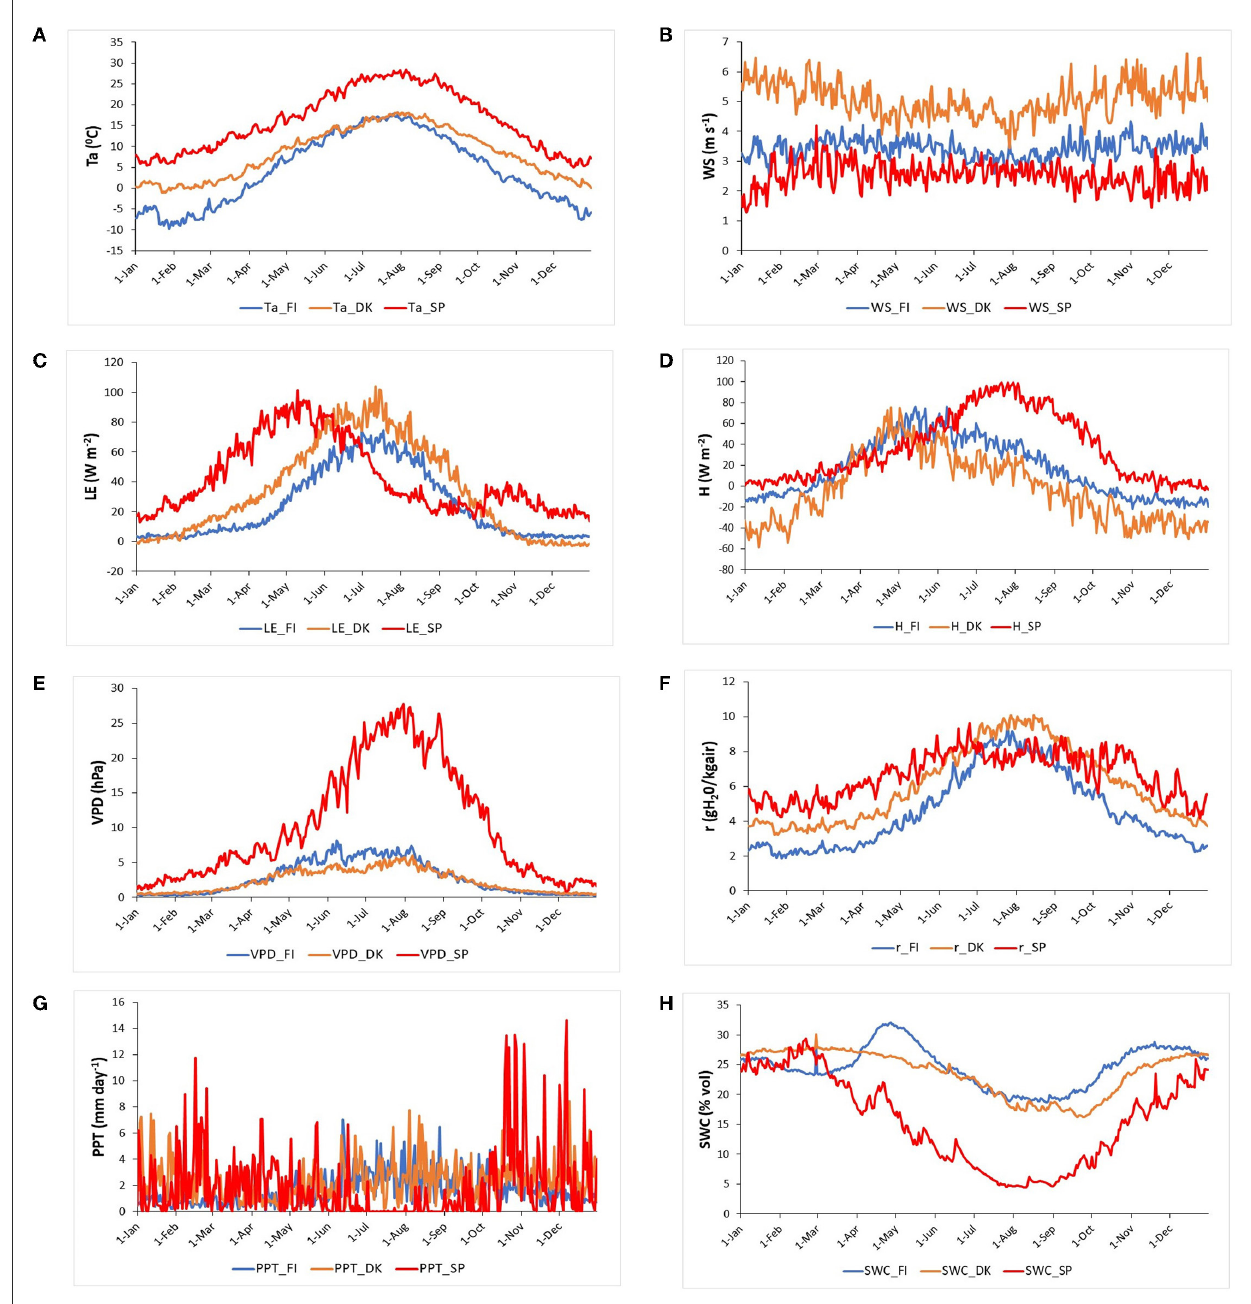
FIGURE3 An average year, i.e., Buys-Ballot, of the daily meteorological and energy fluxes variables for the study period in the three European ecosystems [Evergreen Needleleaf Forest of Finland (ENF_FI, blue line), Deciduous Broadleaf Forest of Denmark (DBF_DK, orange line), and Mediterranean Savanna ecosystem of Spain (SAV_SP, red line)]: (A) Air temperature, Ta ( ◦ C), (B) Wind speed, WS (m s − 1 ), (C) Latent heat flux, LE (W m − 2 ), (D) Sensible heat flux, H (W m − 2 ), (E) Vapor pressure deficit, VPD (hPa), (F) Mixing ratio, r (g kg − 1 ) (G) Precipitation, PPT (mm day − 1 ), and (H) Soil water content, SWC (%